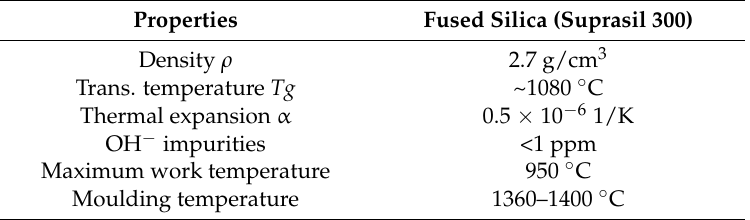
Figure 3. ( Left ) Comparison of different glass types in terms of transmissivity τ over wavelength λ ; ( Right ) Comparison of different glass types in terms of viscosity η over temperature T [5,16,17]. Table 1. Characteristics of Fused silica, type Suprasil 300 [5,14].